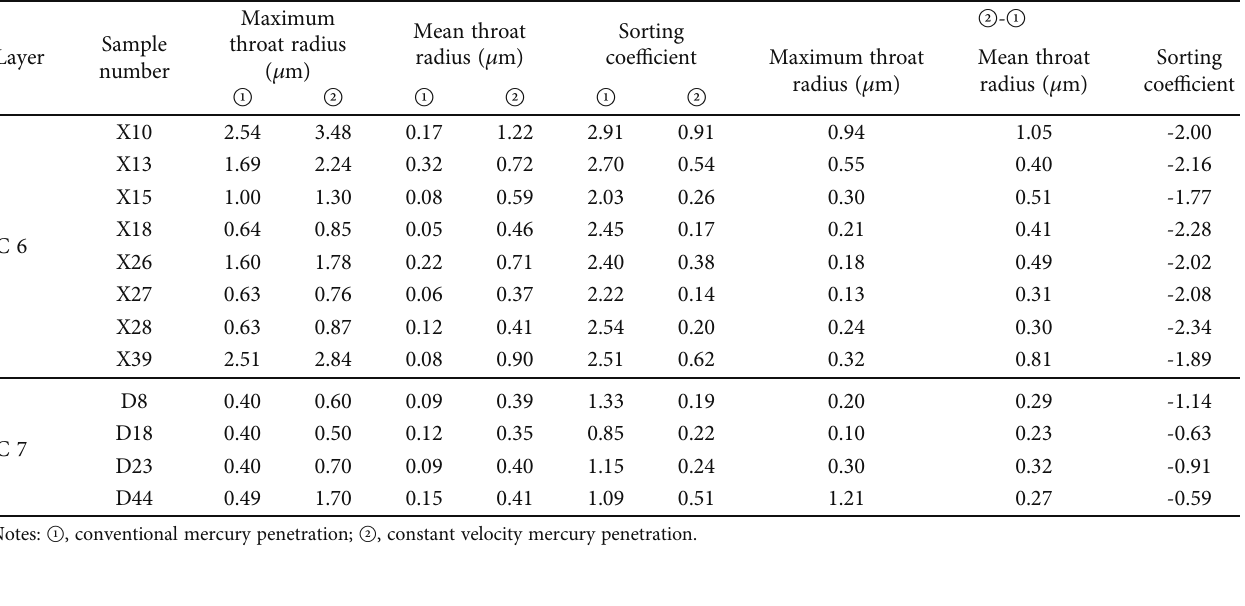
Table 2: Typical parameters of micropore structure.